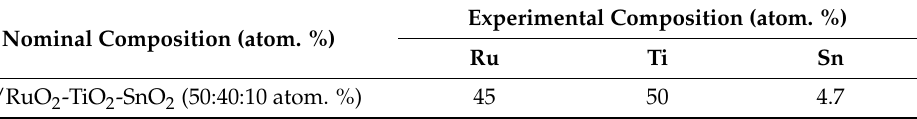
Table 2. Elemental composition of DSA electrode defined by energy dispersive X-ray spectroscopy (EDS). The experimental composition is described in atomic percentage as usually used to describe the elemental composition of electrodic materials. Nominal Composition (atom. %)